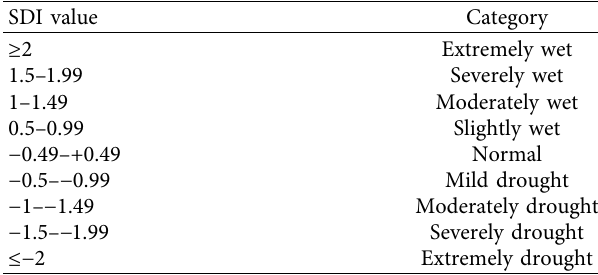
Table 3: Drought classification according to the SDI values (Nalbantis and Tsakiris,